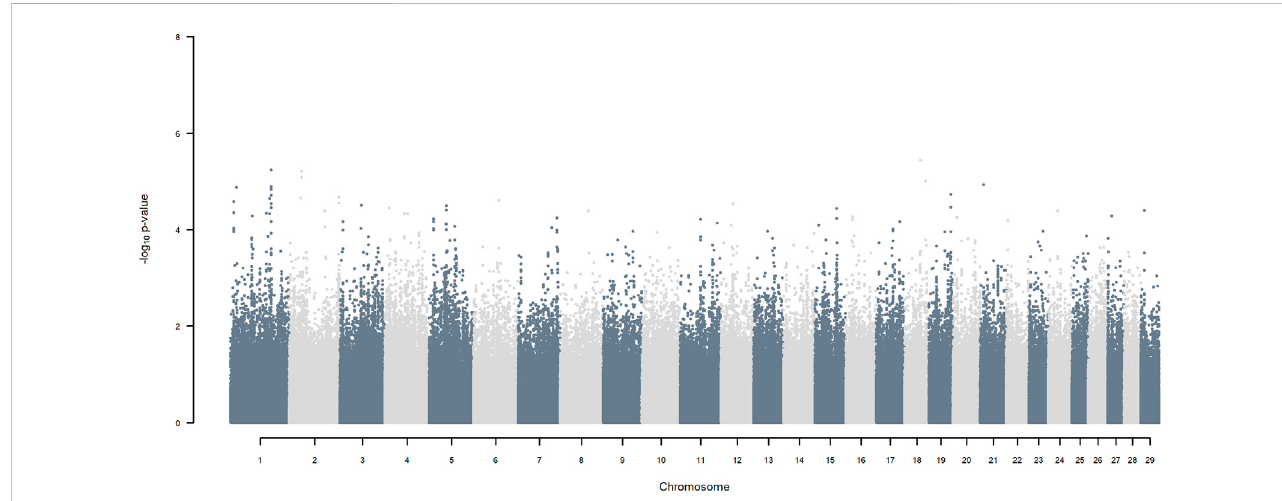
FIGURE 2 Manhattan plot of GWAS (Model 1) in which each SNP genotype was tested for an association with milk